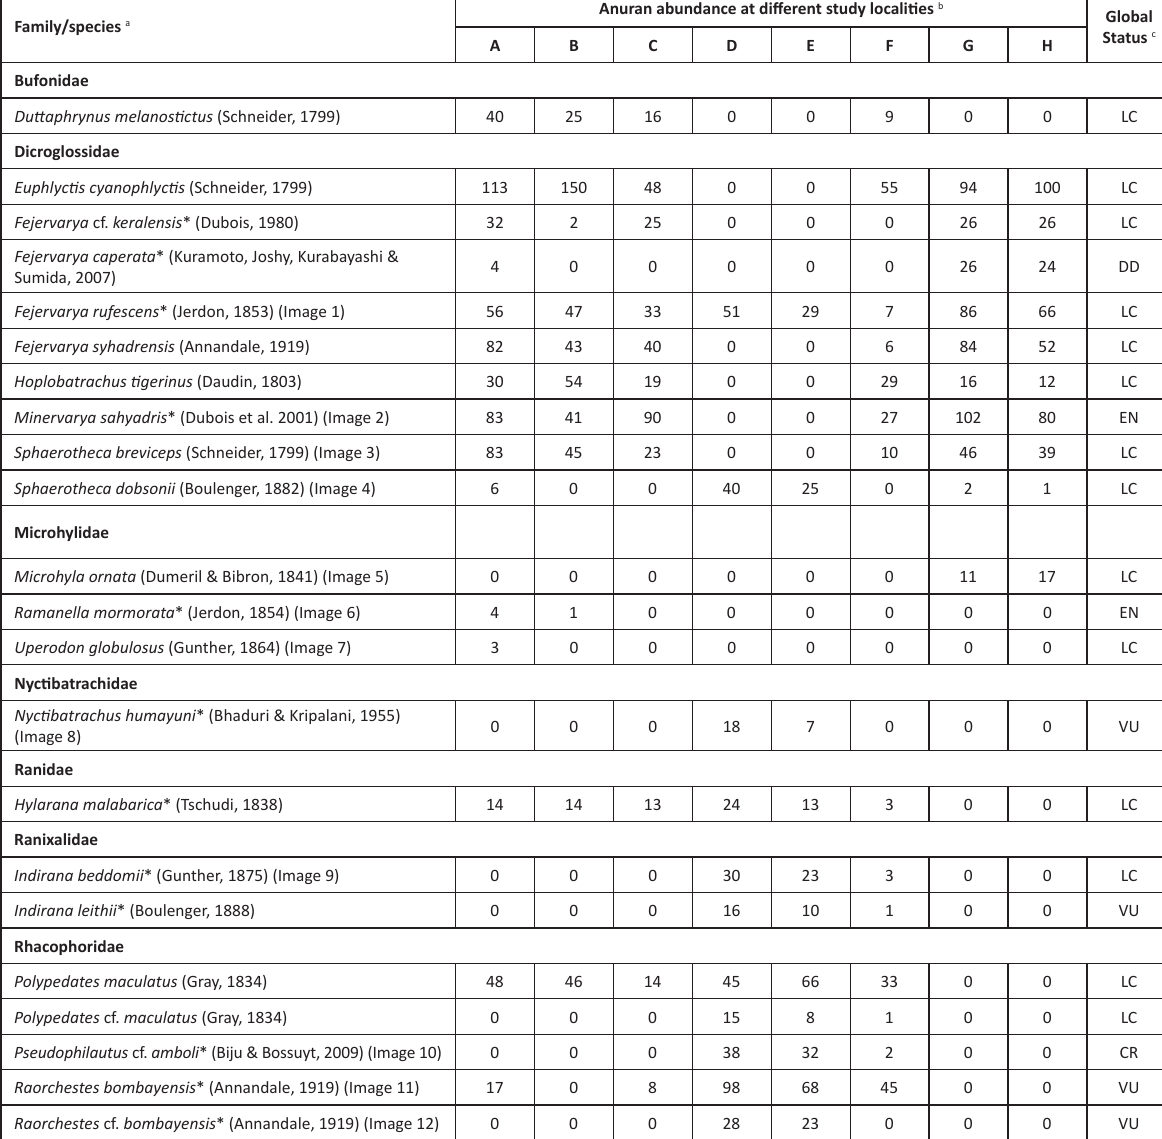
Table 3. Anuran abundance recorded at different study localities in Phansad Wildlife Sanctuary (PWS). Family/species